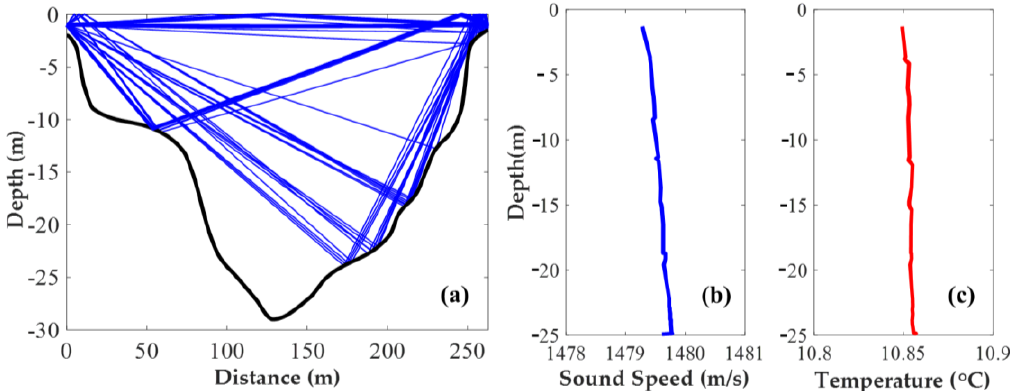
Figure 4. ( a ) Ray patterns of S1-S3 in the range-independent ray simulation; ( b ) Sound–speed profile data measured using conductivity–temperature–depth (CTD); ( c ) Temperature profile data measured using CTD.